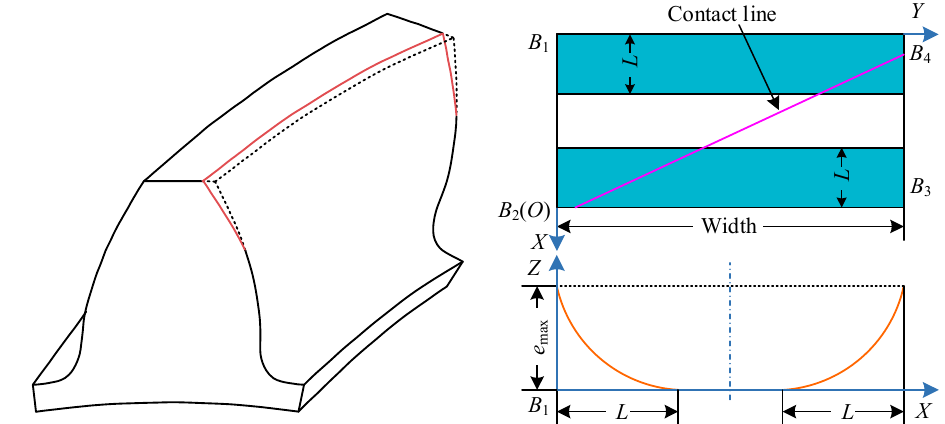
Figure 13. Schematic diagram of profile modification for helical gears.